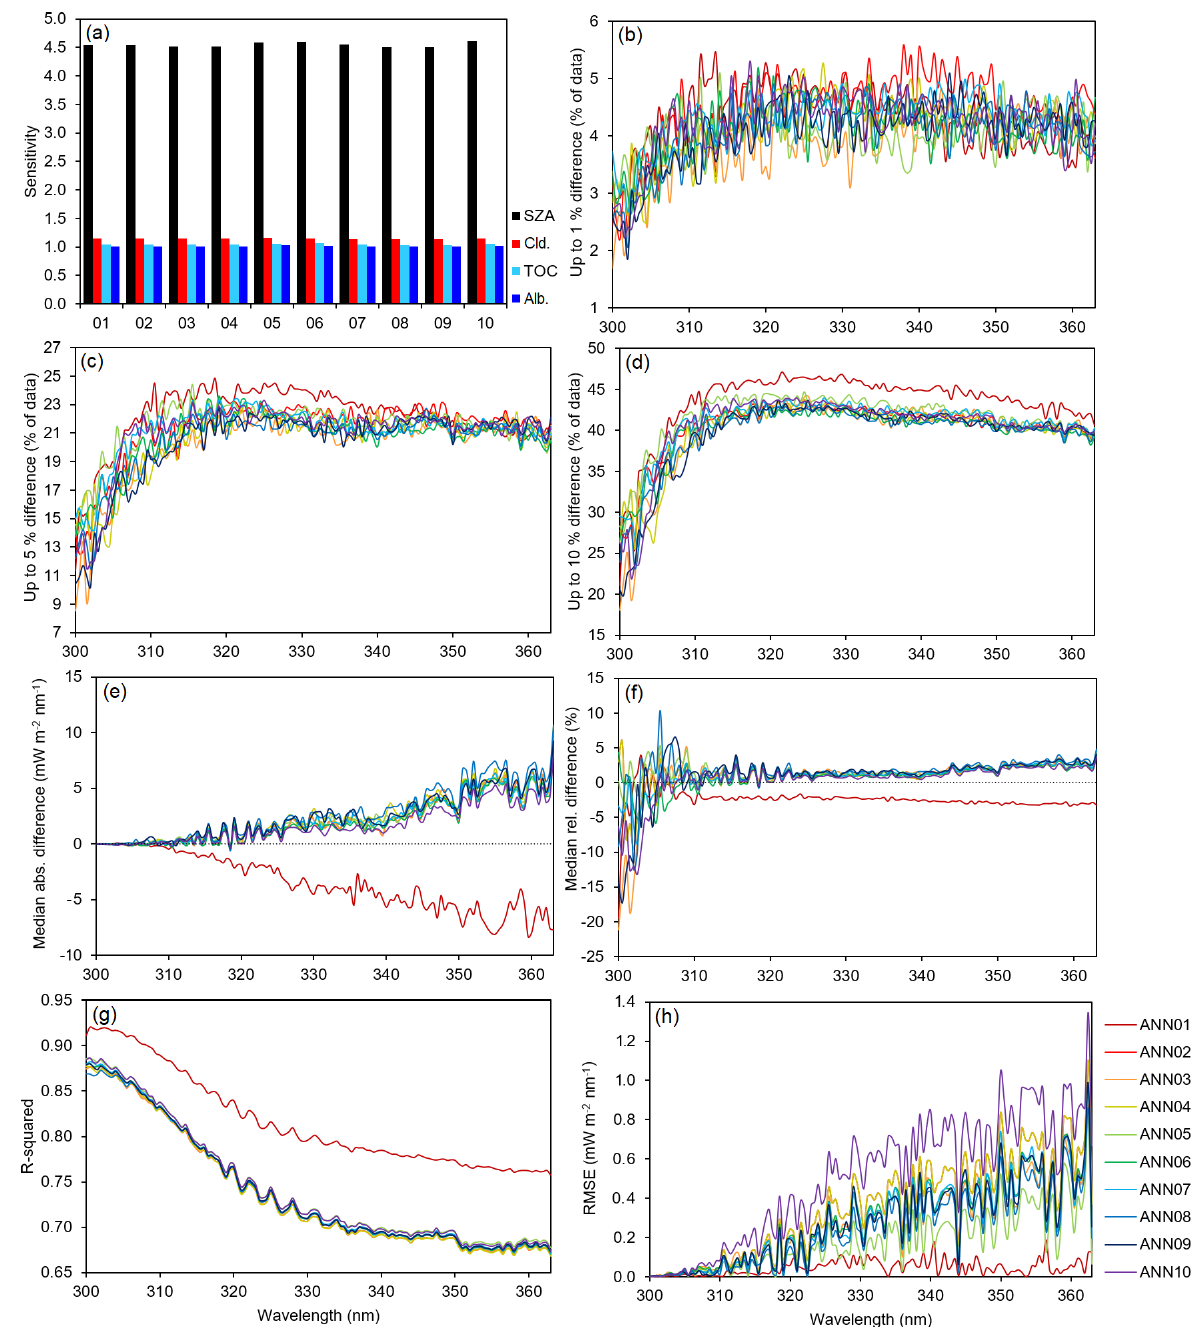
Figure A2. Development and validation of the 10 artificial neural network models, where (a) is the sensitivity of individual models to given variables; (b) , (c) , and (d) show the number of modeled data within 1%, 5%, and 10% difference from observations, respectively; (e) and (f) are the absolute and relative median differences of the modeled data from the observations; (g) shows the R 2 , and (h) is the root mean square error of the individual